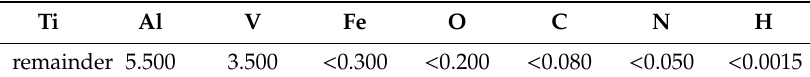
Table 1. Chemical composition of Ti6Al4V alloy (maximum content as a wt %).